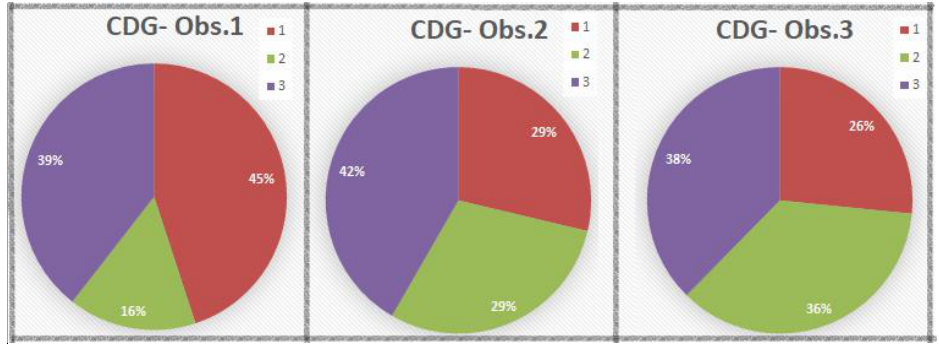
Figure 11. CDG distribution for all